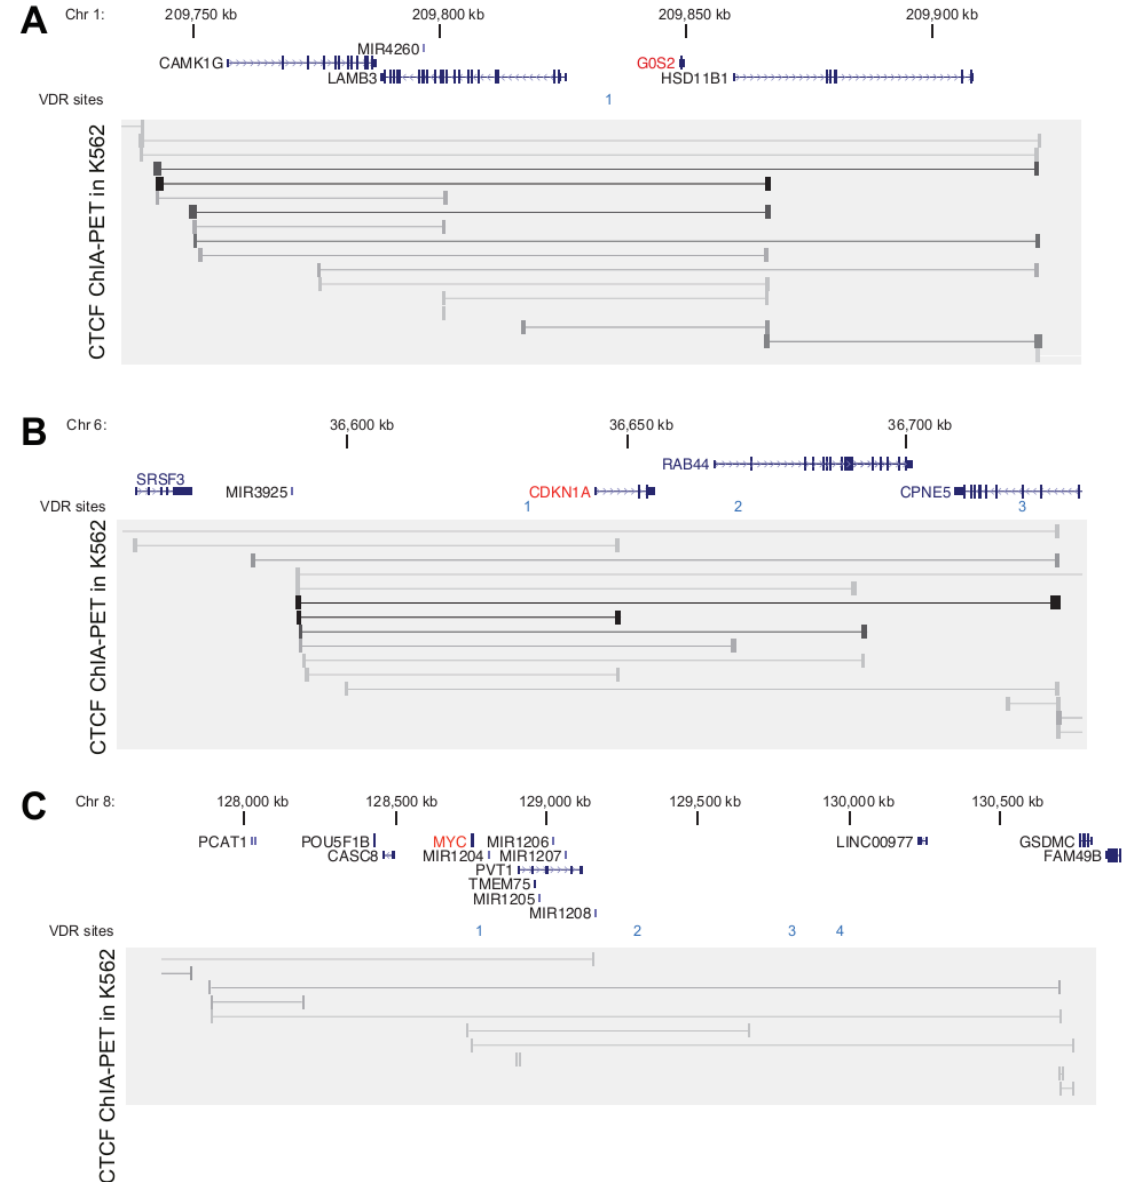
Figure S3. Looping between CTCF sites at the loci of G0S2 (A), CDKN1A (B) and MYC (C). The UCSC genome browser (http://genome.ucsc.edu) was used to display CTCF ChIA-PET data from K562 cells [32] for the same genomic region as shown in Figure 2. Horizontal lines represent chromosomal domains formed by DNA looping between CTCF sites. The positions of the VDR peaks are indicated by numbers and the gene structures are shown in